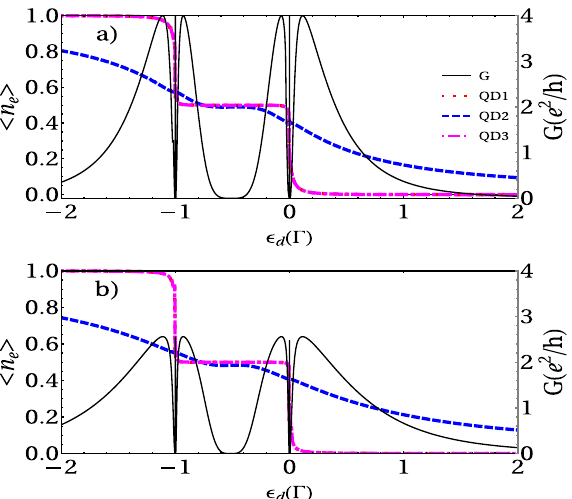
Figure 4. Electronic occupation and linear conductance of a TQD system calculated as a function of the dot’s level energy for ( a ) r